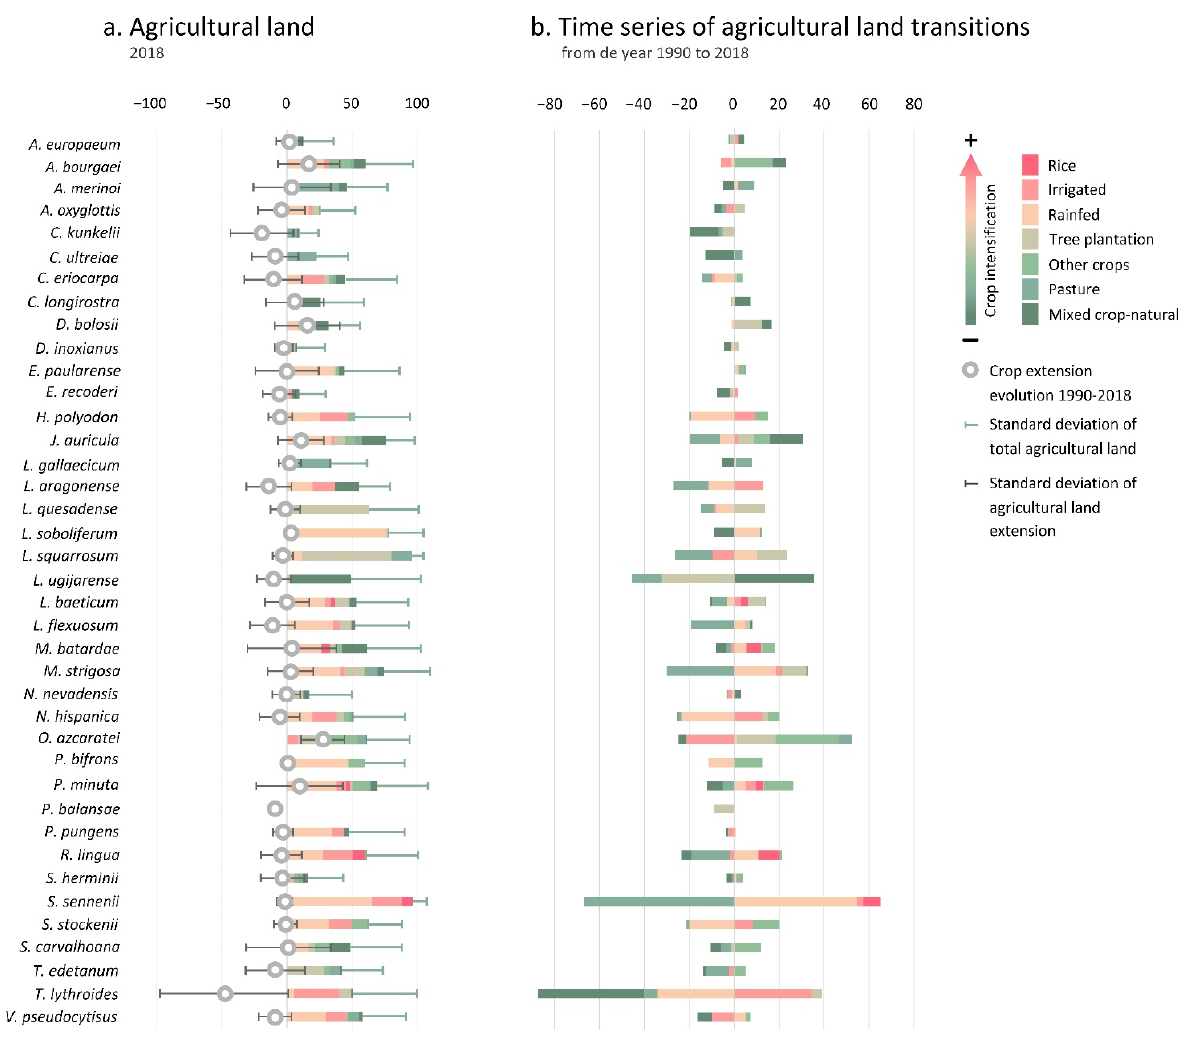
Figure 2. Taxa threatened by the extension of cultivation. ( a ) Agricultural land. The figure shows the total area of agricultural uses, according to CORINE, of the area of influence of taxa threatened by the extension of cultivation in 2008. The dot indicates the evolution of the agricultural land use area for each taxon between 1990 and 2018. ( b ) Time series of agricultural land uses. The figure shows, for each taxon, the trend of expansion or reduction of agricultural use between 1990 and 2018 according to CORINE.